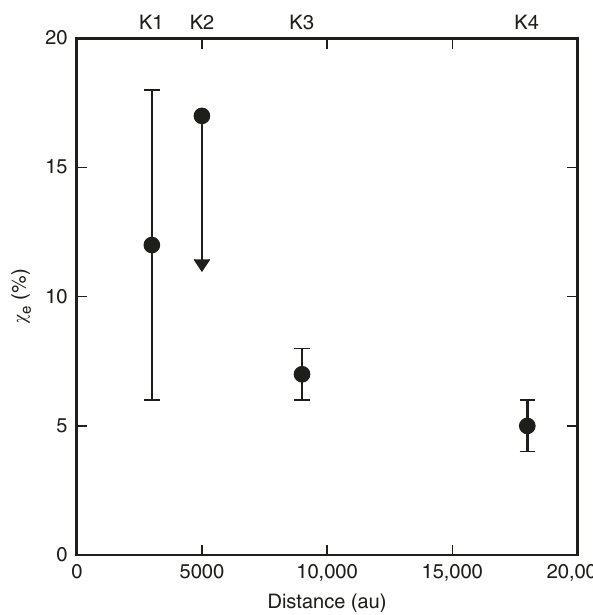
Fig. 3 Ionisation fraction versus distance. Evolution of the ionisation fraction along the jet with distance to the source. The source of uncertainties is coming from the error propagation calculated from the ionisation fraction equation and the errors are 6% (K1), 1% (K3), and 1% (K4), K2 being